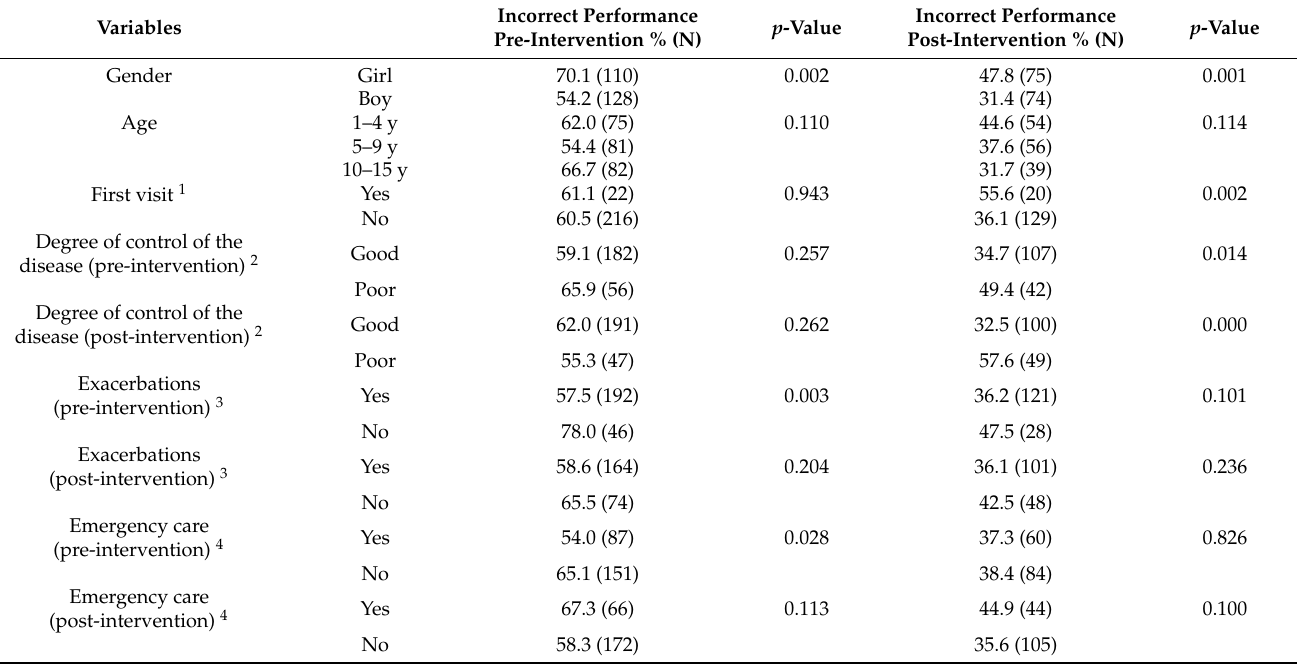
Table 1. Risk factors of the failure in the performance of the inhalation technique in children with respiratory disease before and after the education intervention. Results from the Crosstabs using Chi-square test (significant differences were considered at the 0.05 significant